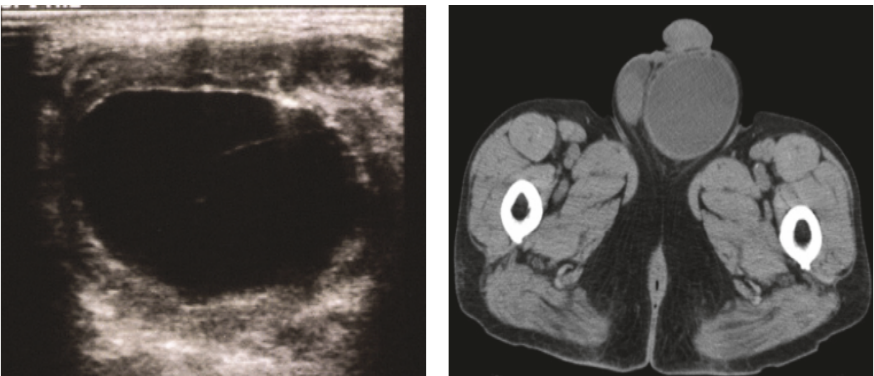
Figure 1: Seroma was diagnosed by ultrasonography (left) or computed tomography